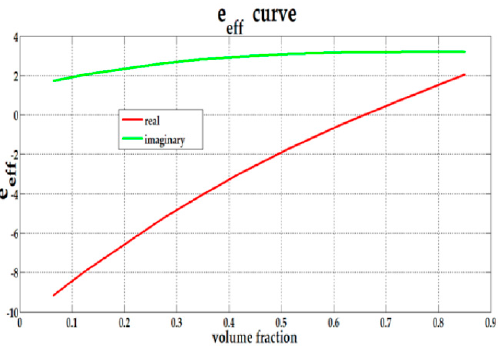
obtained from Equation (5).